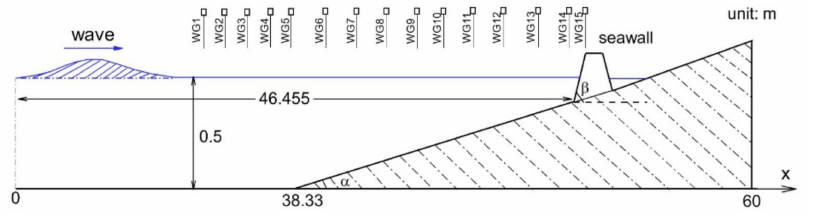
Figure 12. Computational layout for the tsunami-like wave overtopping the